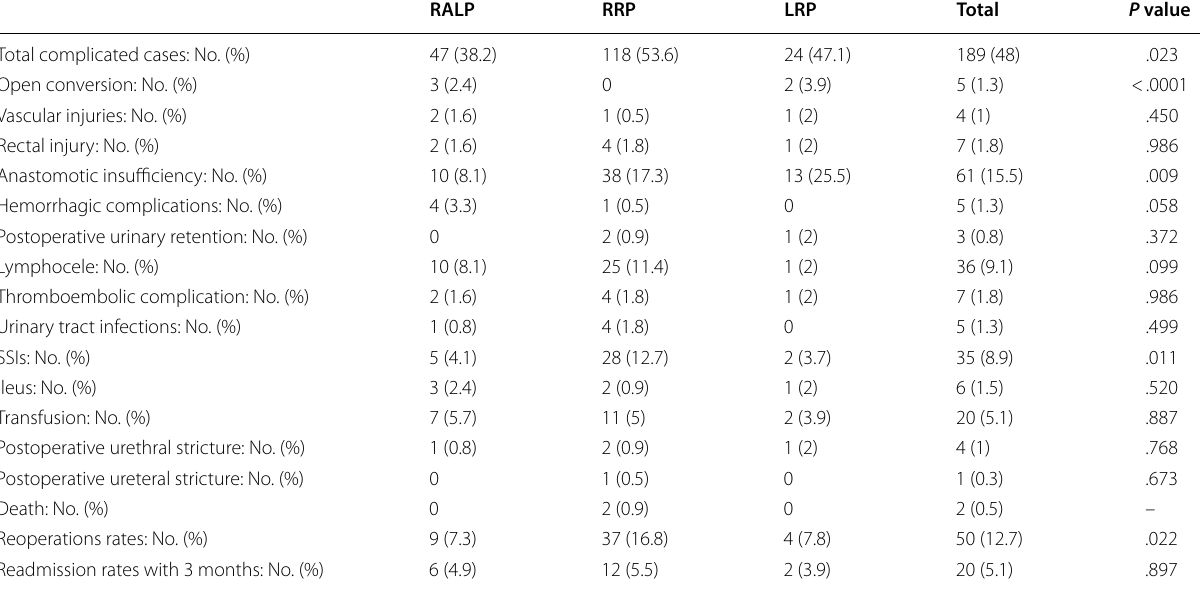
Table 4 Overall and specific complications after RPs RALP RRP LRP